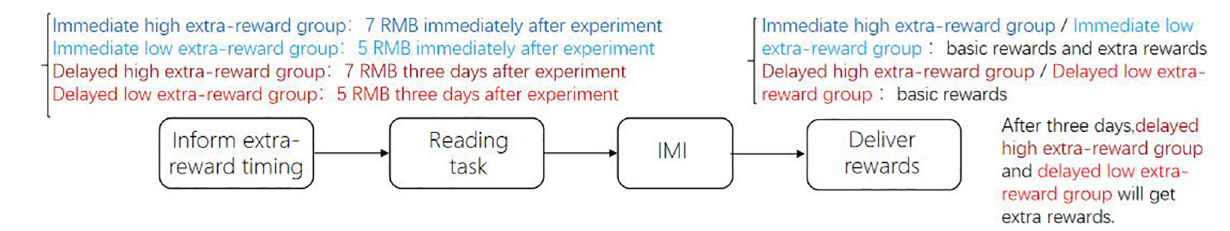
FIGURE 8 | Experimental procedure of Study 3.